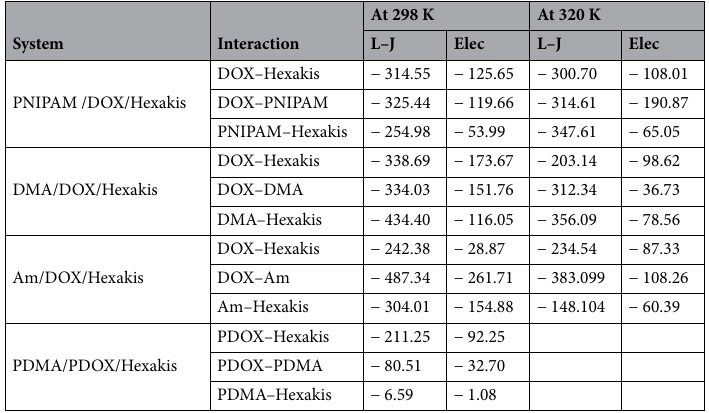
Table 2. A summary of the characteristics of the amino acids is explored in this